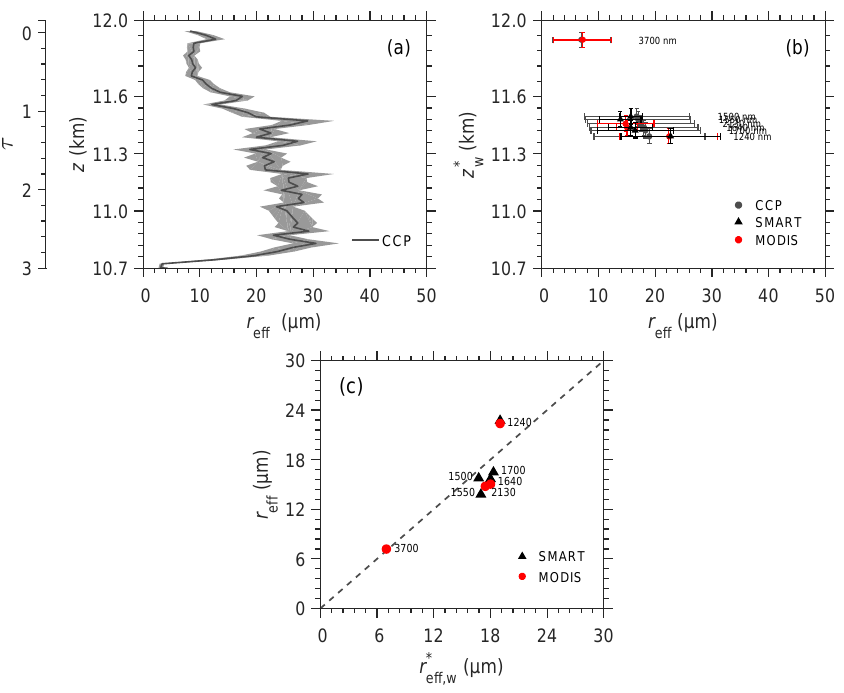
Figure 15. (a) Profile of effective radius r eff (z) derived from in situ CCP (solid line) with the corresponding uncertainties (grey area). (b) Comparison of the in situ r ∗ and the mean value of r eff retrieved from SMART and MODIS using λ between 1240 and 3700nm. eff , w Horizontal error bars represent the standard deviation of r eff , while vertical error bars are the uncertainty of z ∗ w . (c) Scatter plots between the in situ r ∗ and the mean value of retrieved r eff . The dashed line is the one-to-one line. The labels at each data point describe the eff , w wavelengths used to retrieve the r eff